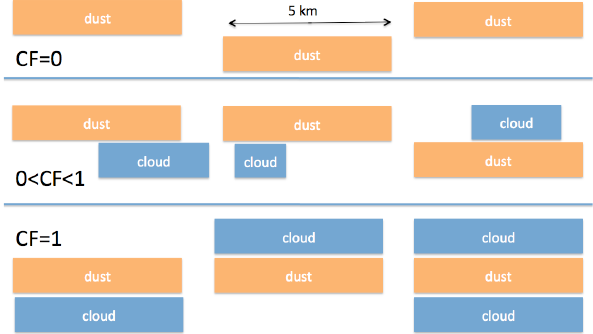
Fig. 3. Schematic illustration of Cloud Fraction (CF) definitions for Figure 3. Schematic illustration of Cloud Fraction (CF) definitions for 5 km resolution dust 3 5km resolution dust pixels. CF is the fraction of cloudy 0.3km- pixels. CF is the fraction of cloudy 0.3 km-resolution pixels in 5 km size areas containing 4 resolution pixels in 5km size areas containing dust. 5 6